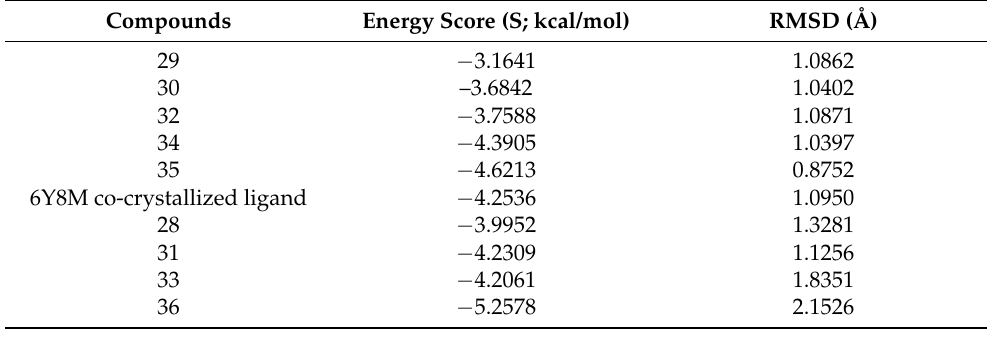
Table 6. Binding free energy score (S; kcal/mol) with binding interactions for different co-crystal- lized ligands and compound 28 within TNF α (PDB ID: 2AZ5); TGFBR1 kinase (PDB ID: 6B8Y); and IL-1 β (PDB ID: 6Y8M) binding sites.